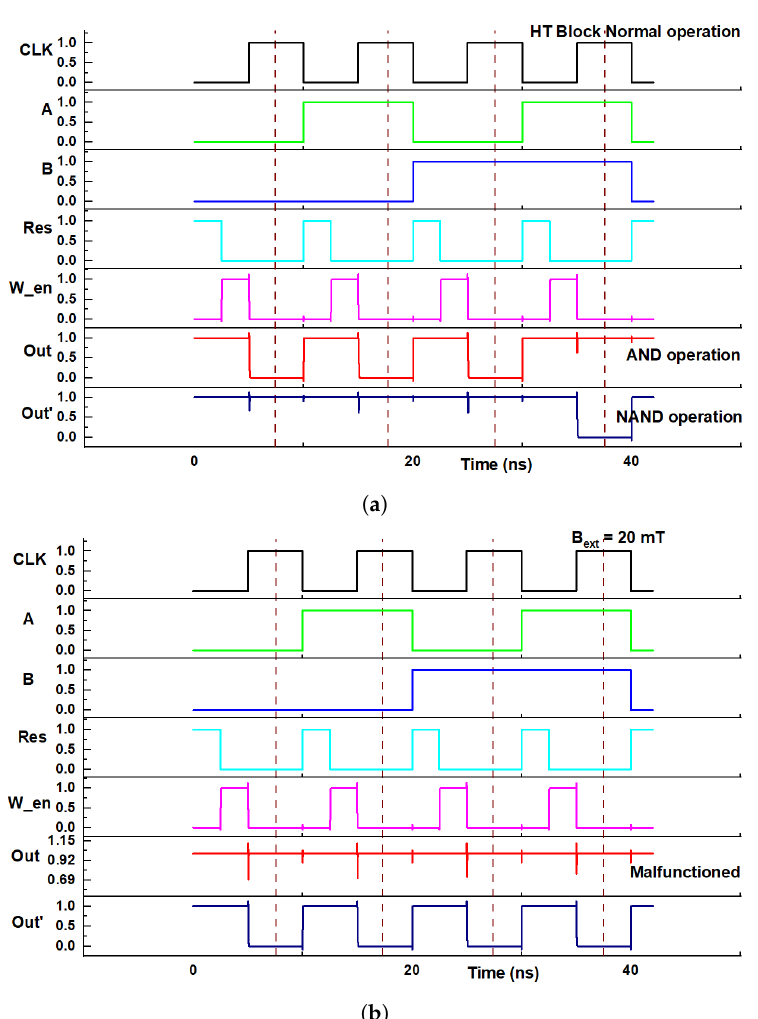
Figure 6. ( a ) Hardware Trojan block waveforms under normal operation (hidden behavior). ( b ) Hard- ware Trojan block waveforms under triggered operation (malfunction